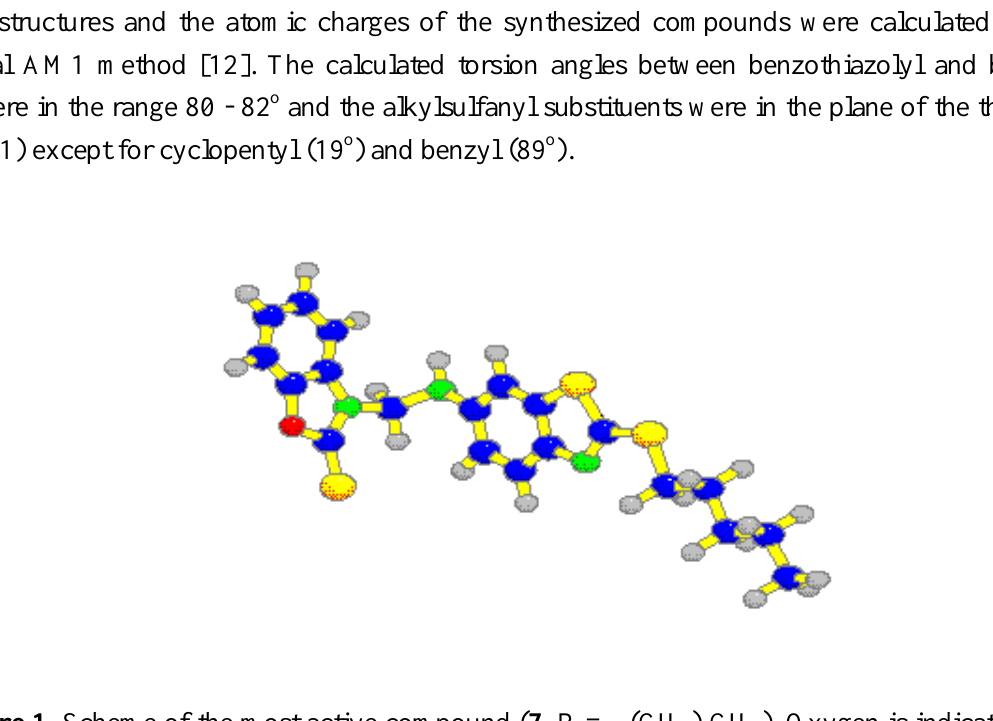
nitrogen by green and sulphur by yellow